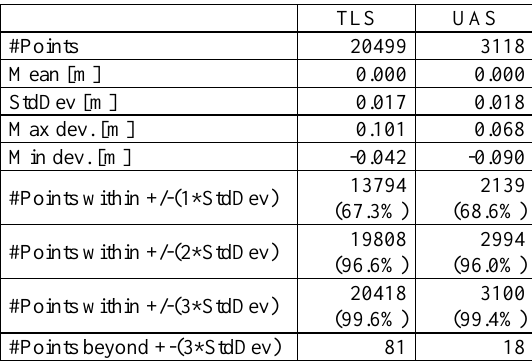
Figure 14. Detection of a terrain kink in the UAS model